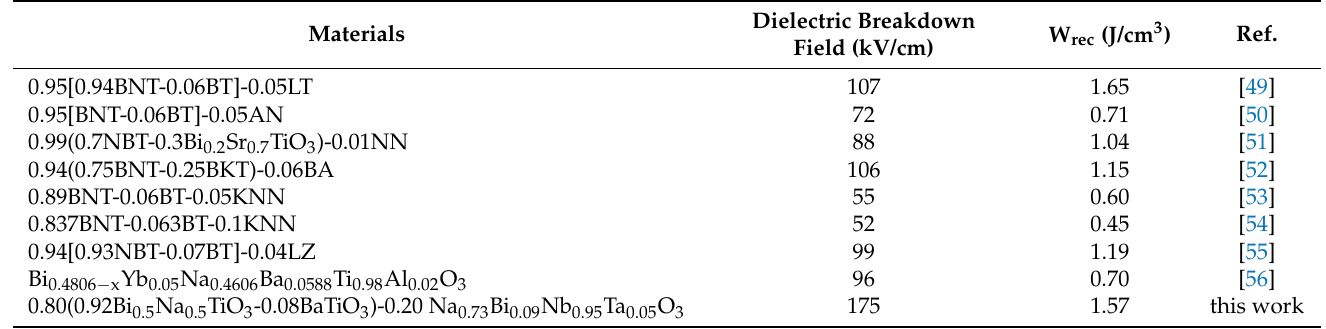
Table 1. The comparative analysis of the current study with previously published works on NBT- based